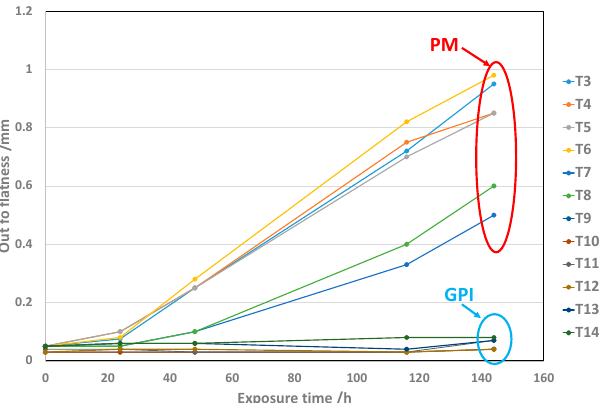
Figure 5. Evolution of the deformation in the function of time of subassemblies, including PM or GPI adapters, respectively. The subassemblies were exposed to 50 °C and 100% RH for increasing times up to 144 h. Their deformation was regularly measured during the exposure. The deformation reported in the y-axis represents the maximum measured sagitta for the respective times of exposure.